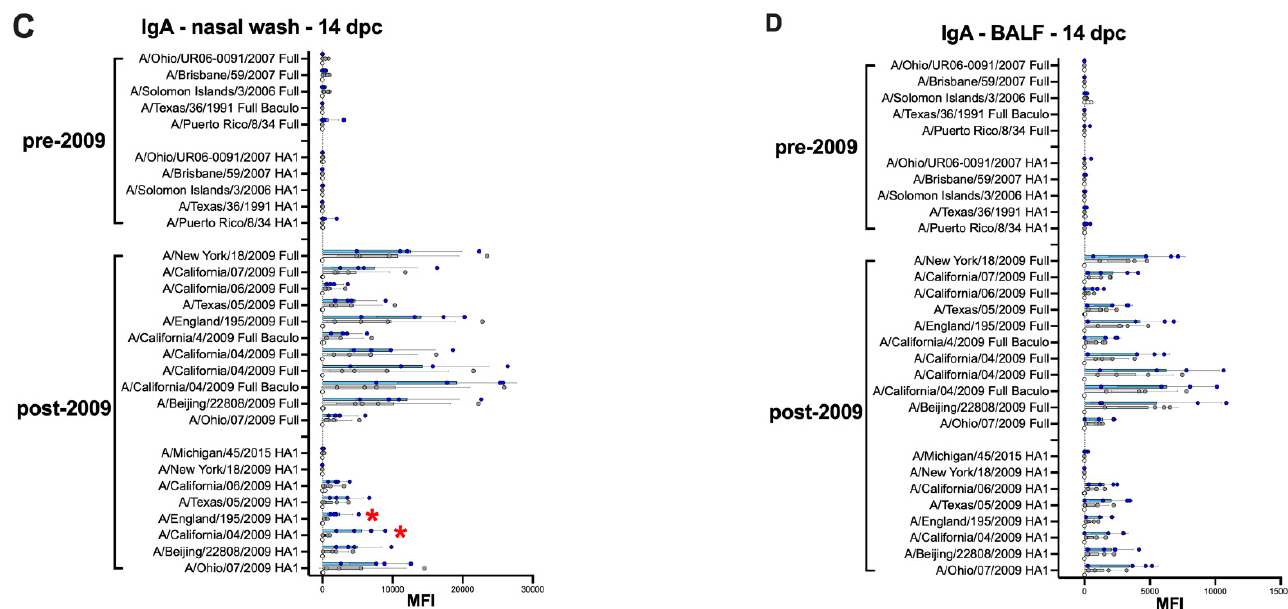
Figure 8. Mucosal IgG and IgA responses 14 dpc in IGIP-H1att- and H1caLen-vaccinated mice. Mice ( n = 4/group) were humanely euthanized at 14 dpc, and nasal washes ( A , C ) and BALFs ( B , D ) were collected to evaluate the levels of IgG ( A , B ) and IgA ( C , D ) antibodies against H1 HAs on the protein microarray. The reactivity of samples in main graphs and insets is expressed as described in Figure 4 and results shown as MFI ± SD. The statistically significant differences between IGIP-H1att and caLen are depicted with red asterisks.